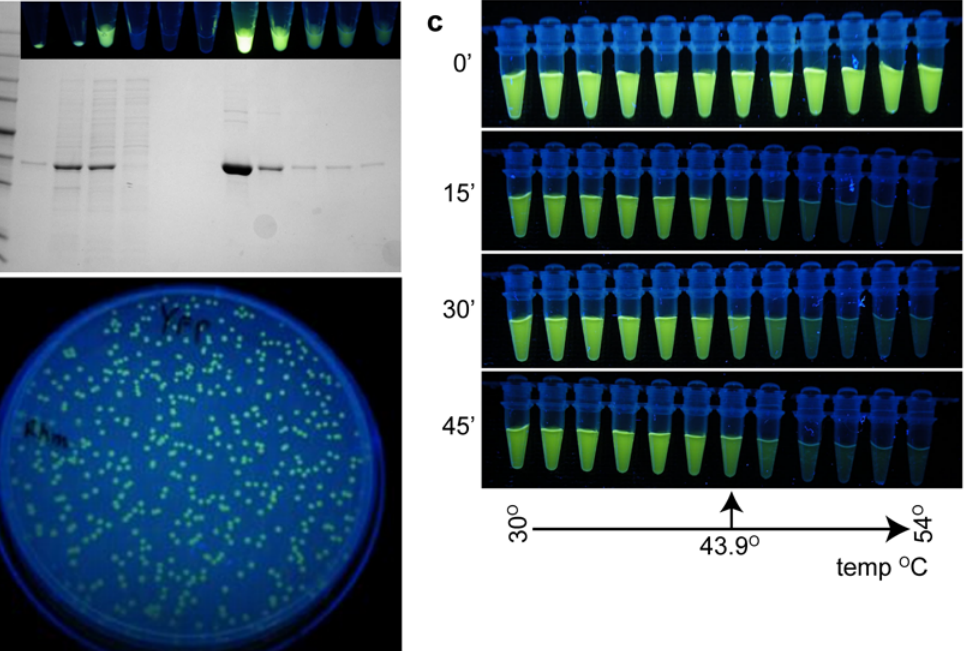
Fig 1. LucY characteristics. (a) His tagged LucY was purified by metal affinity chromatography. Lanes are: protein marker, whole cells, pellet, supernatant, column flowthrough, wash, and elutions. Fractions were photographed under UV light (inset) and are aligned with corresponding gel lanes (b) LucY fluorescence is visible in E. coli colonies grown on a LB plate. (c) Purified LucY was subjected to a temperature gradient (30 to 54°C) in a thermal cycler. Samples were photographed after exposure to elevated temperatures for the time indicated.